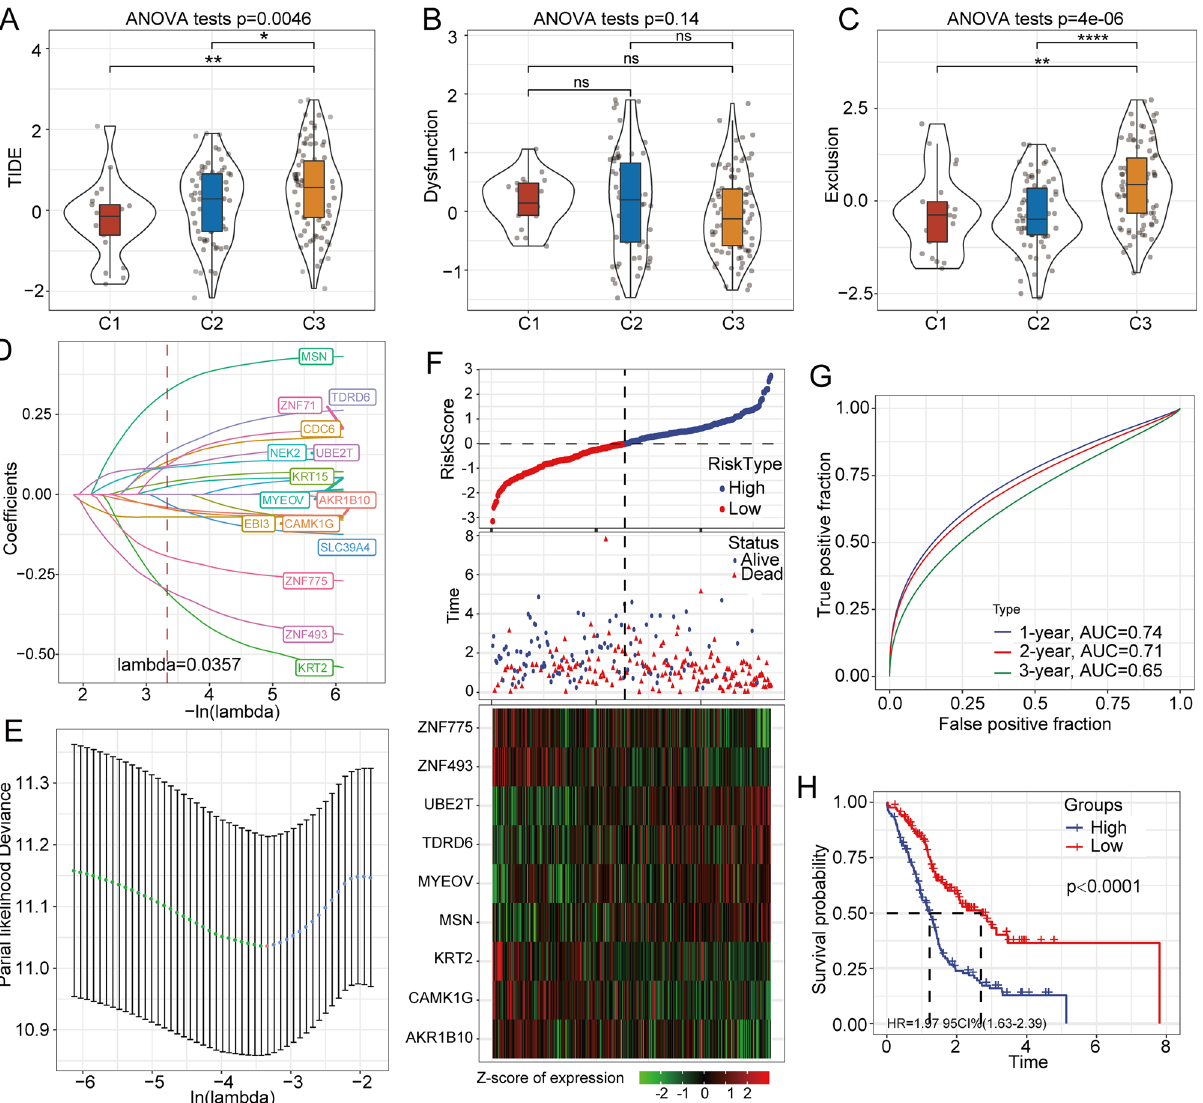
Figure 6. Prediction of the immunotherapy effects of different epi-PCG clusters and construction of a prognostic risk model based on epi-PCGs. ( A ) Difference in TIME scores among different epi-PCG clusters. ( B ) Difference in T cell dysfunction among the three clusters. ( C ) Difference in T cell exclusion among the three clusters. ( D ) Change trajectory of each independent variable. ( E ) Confidence interval under each lambda. ( F ) Distribution of the risk score, survival time and survival status and the expression levels of the 9 genes in the ICGC dataset. G. ROC curve and AUC of 9-gene model classification. ( H ) Survival analysis of patients with high or low risk scores in the ICGC